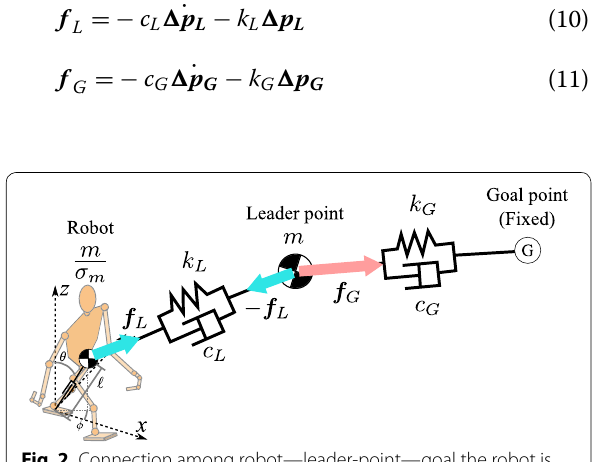
Fig. 2 Connection among robot—leader-point—goal the robot is towed by the virtual leader point, which is also towed by the goal; their connections are given as damping and spring